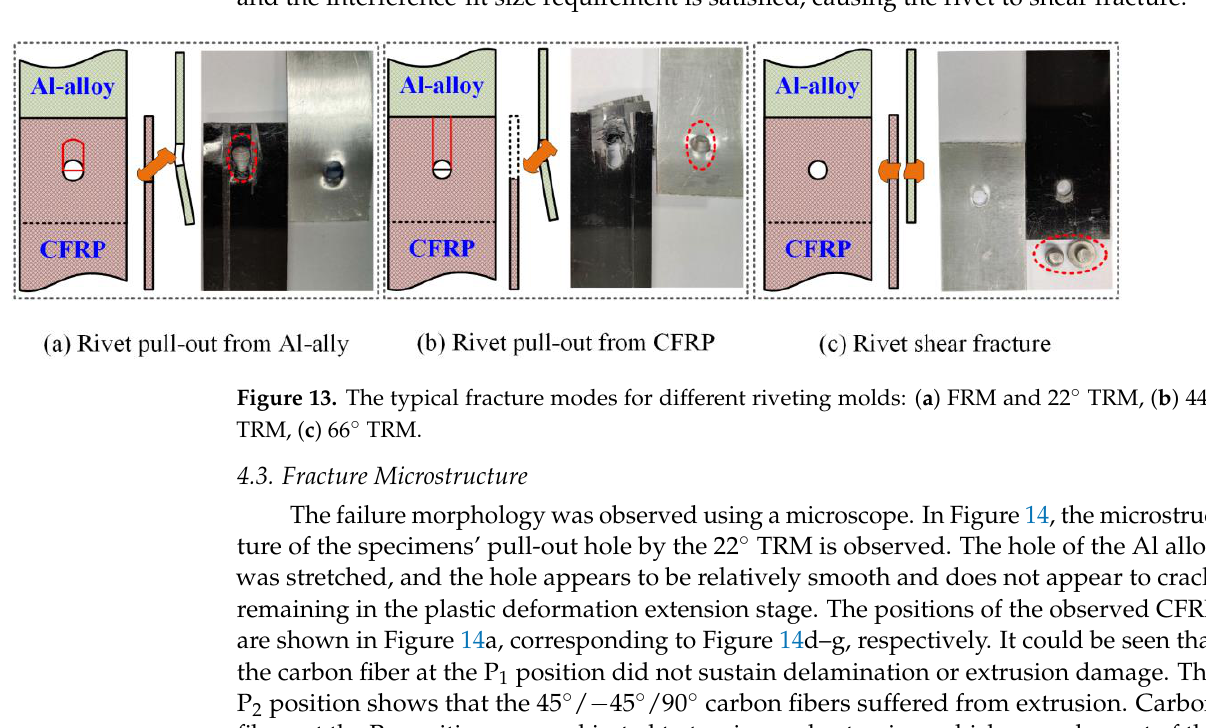
11 of 14 Figure 12. The tensile load-displacement curves with different TRM angles.